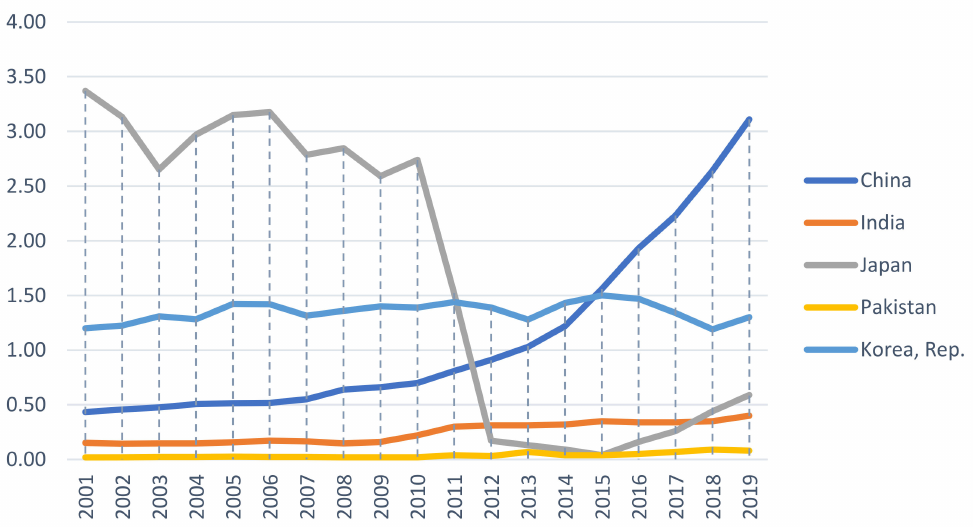
Figure 2. Nuclear energy consumption in selected Asia Pacific countries source: Global footprint network